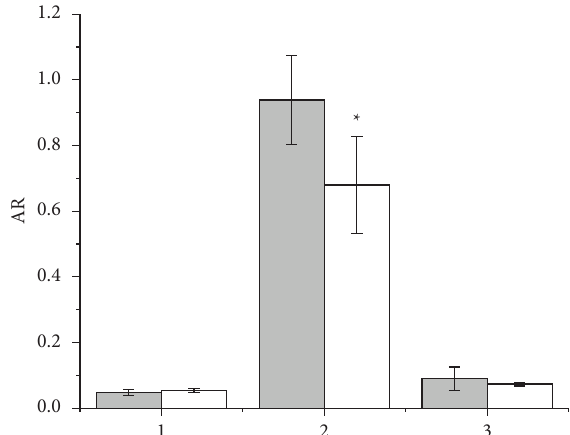
Figure 5: AR in A2780 cells treated for 1 h with 1 , 2 , and 3 (10 μ M) in the absence (gray bar) or in the presence (white bar) of NaN 3 and 2-deoxyglucose (NaN 3 /2DG, pretreatment, both 25mM). Data are the mean ± SD of three independent replicates and were compared using one-way analysis of variance (ANOVA) with the Tukey post- hoc test. Statistical analysis (treated vs. untreated): no indica- tion � not signifcant, ∗ p < 0.05.